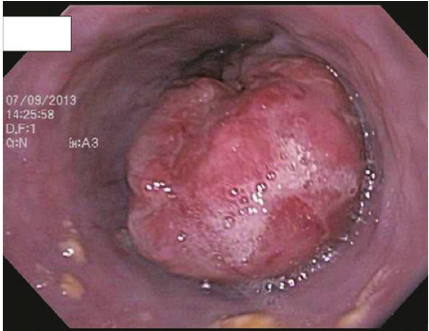
Figure 1: Multiple hyperpigmented, well-demarcated and raised lesions with “stuck-on” appearance are seen on both sides of the neck.